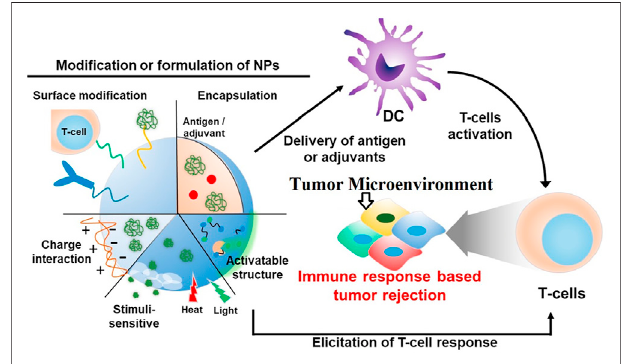
FIGURE 5 | tumor antigen-speci fi c T-lymphocytes for cancer immunotherapy. During cancer immunotherapy, after preparation and presentation of antigen by different molecular methods on dendritic cells, T cells are activated. Immune cells are one of the most important components. Activation of T cells is associated with the development of a speci fi c immune response and destroys the tumor (Yoon et al.,